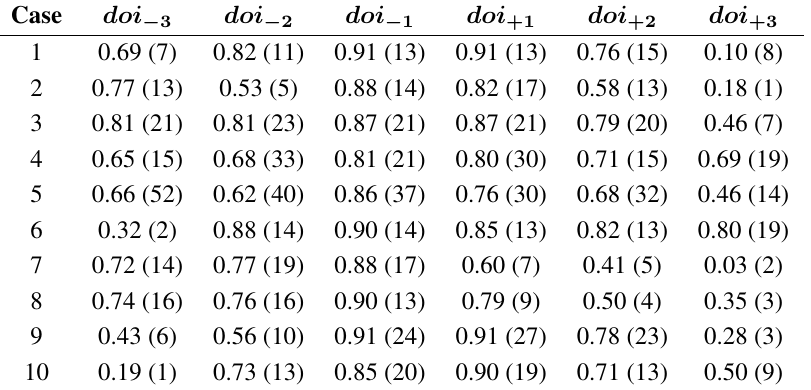
Table 1. Summary of the spatial correlation coefficients between the polynya area of the initial day of interest (doi) and the polynya area of the surrounding days ( doi for the ten constant clear-sky case studies. Numbers in parenthesis indicate the percentage cloud-covered fraction (%) in the respective daily MODIS